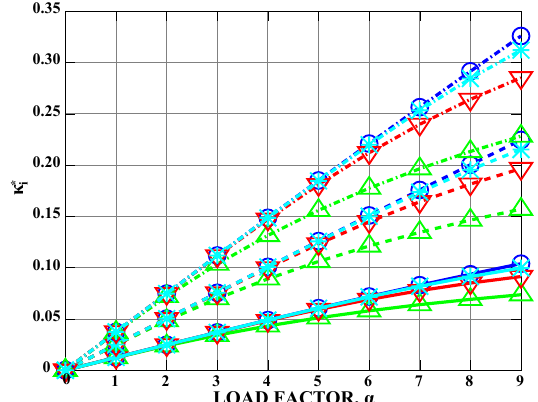
Figure 7. Components of the stretch vector: ε ∗ (dashed line), ε ∗ (dash-dotted line). Case 1a ( (cid:13) ), 1b ( 4 ), 1c ( 5 ), 3 1d ( ∗ ).